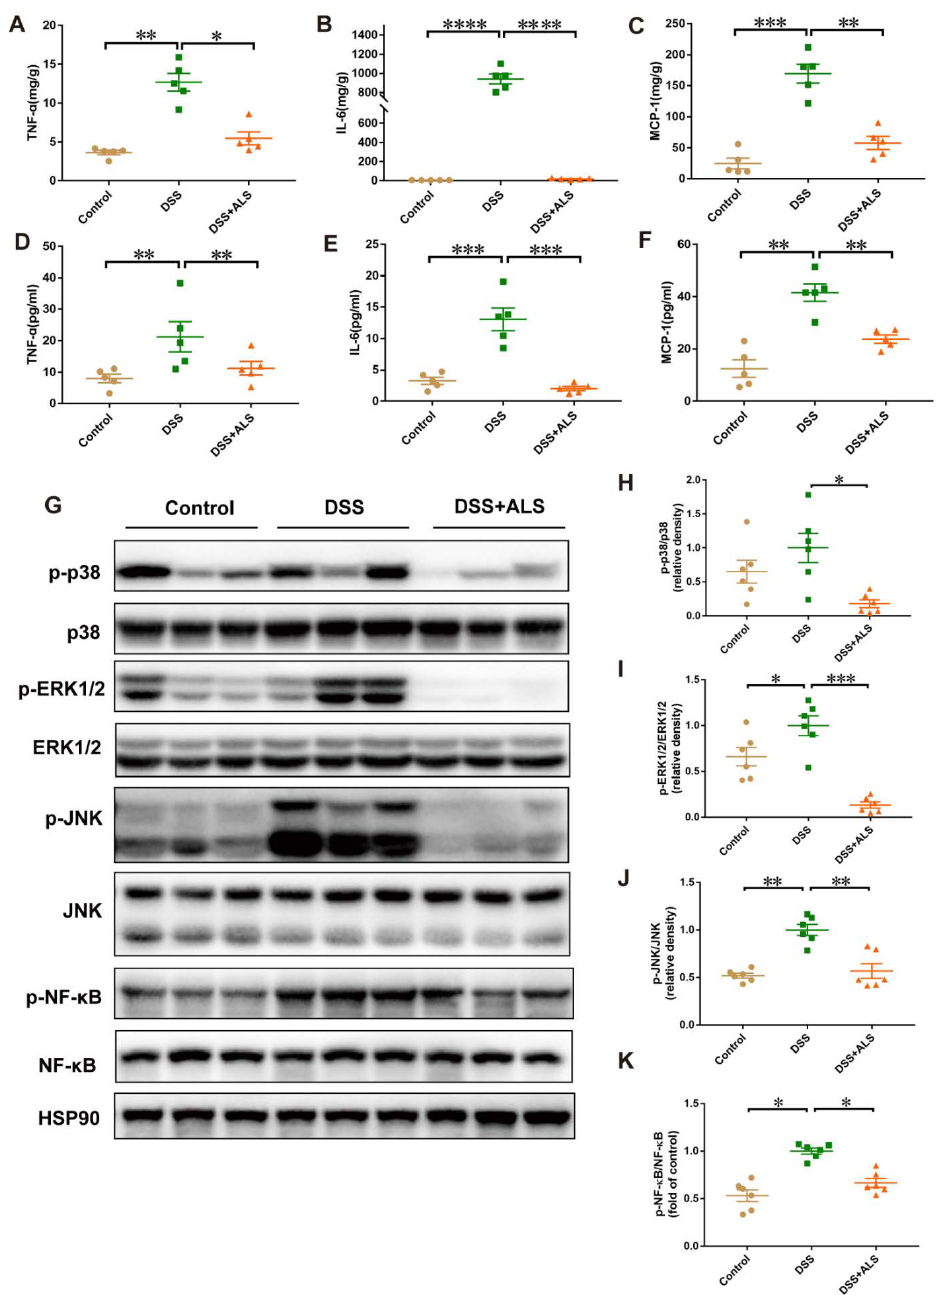
Figure 4. ALS mitigates inflammation in experimental colitis induced by DSS. ( A – C ) Concentration of pro-inflammatory cytokines, TNF- α , IL-6, and MCP-1 in colon tissue. ( D – F ) Concentration of pro-inflammatory cytokines, TNF- α , IL-6, and MCP-1 in serum. ( G ) Western blot results of p-p38, p38, p-ERK1/2, ERK1/2, p-JNK, JNK, p-NF- κ B, and NF- κ B. ( H ) Quantification of p-p38/p38 is shown. ( I ) Quantification of p-ERK1/2/ERK1/2 is shown. ( J ) Quantification of p-JNK/JNK is shown. ( K ) Quantification of p-NF- κ B /NF- κ B is shown. Data are mean ± SEM. n = 5–6 per group. * p < 0.05, ** p < 0.01, *** p < 0.001, and **** p <